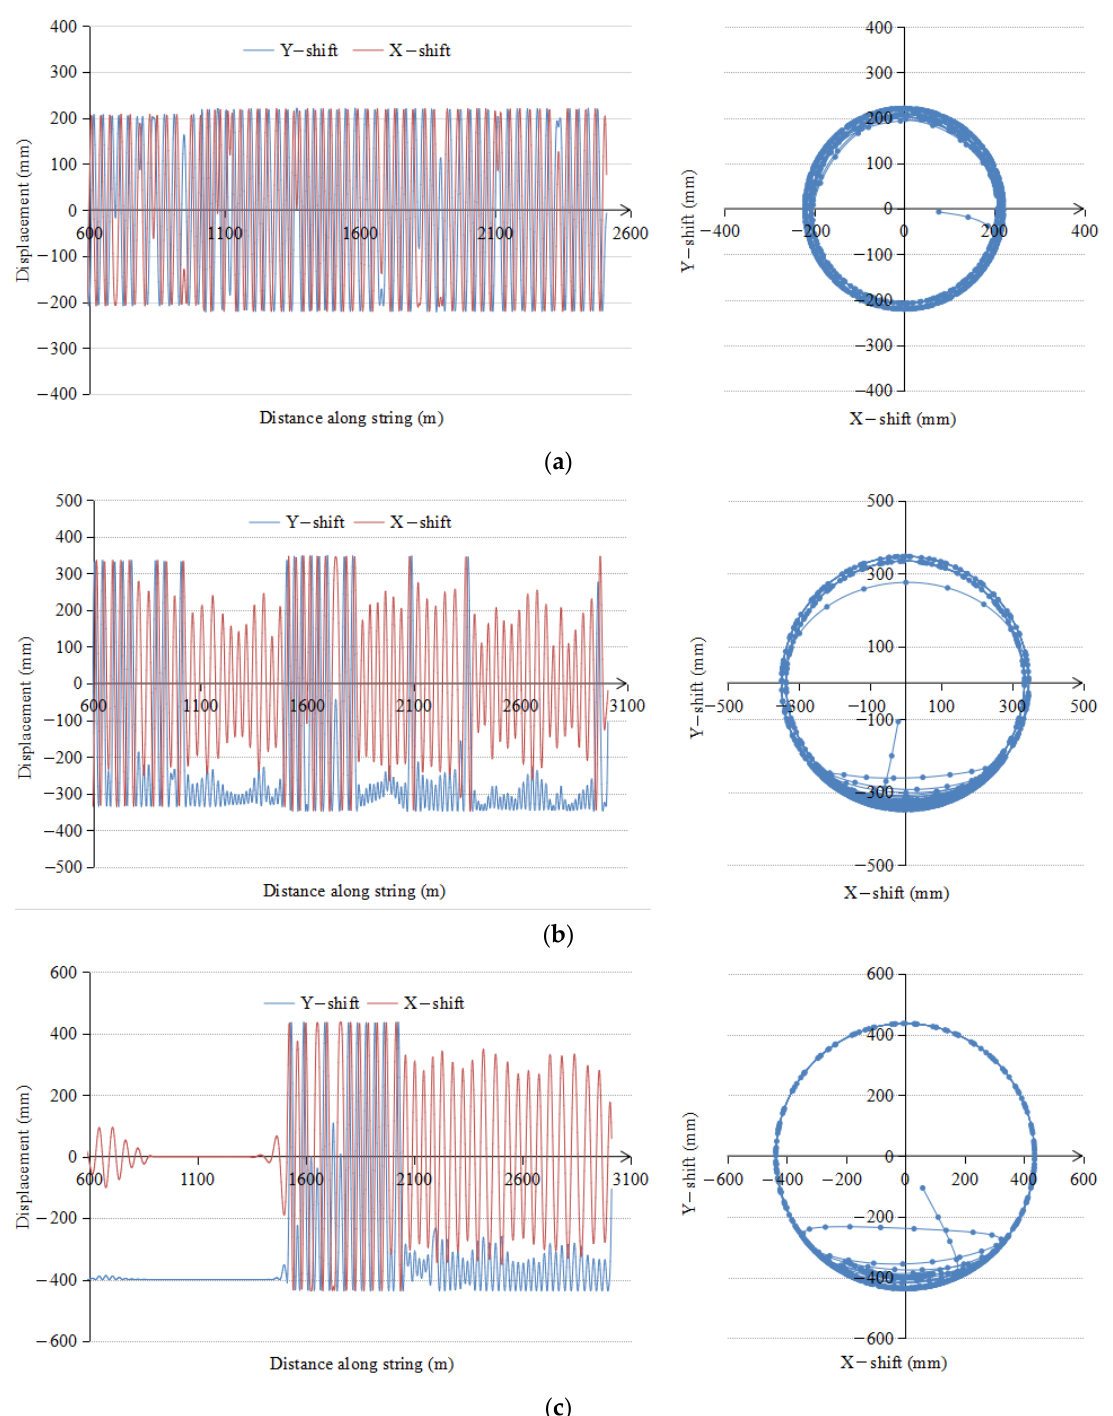
Figure 14. Displacement distribution of DS. ( a ) The first stage reaming. ( b ) The second stage ream- ing. ( c ) The third stage reaming. ( c ) The third stage